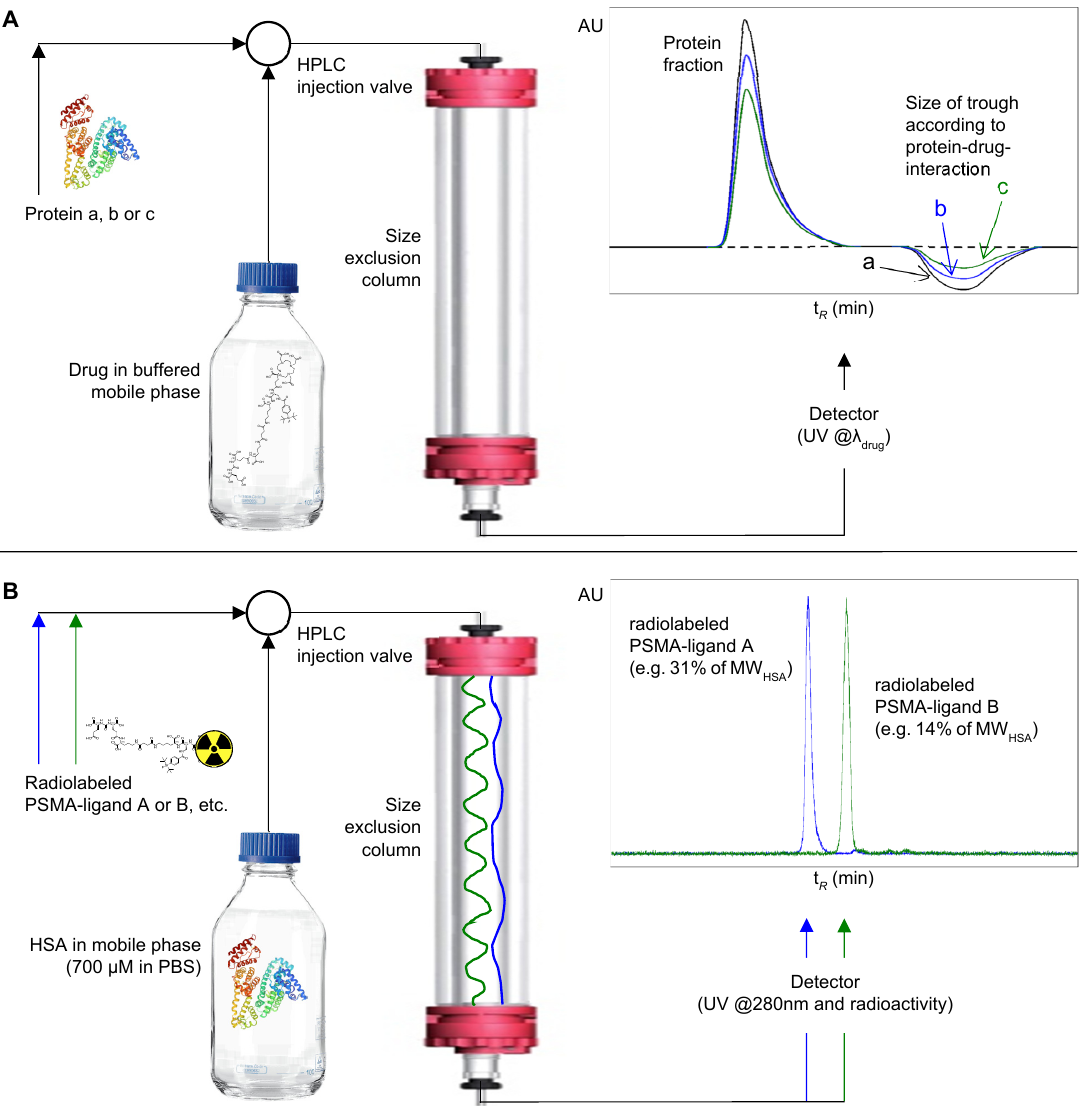
Figure 1. ( A ) Experimental setup of the Hummel–Dreyer method. This method was introduced 1962 to investigate the binding of a drug to proteins. For this purpose, a protein is injected onto a size exclusion column equilibrated with a buffered solution of a drug. After injection, drug molecules from the mobile phase are complexed to the injected protein until equilibrium is reached. The troughs (a, b, c) observed at the cut-off volume in the UV elution profile correspond to the different amounts of drug complexed by the different injected protein samples, thus representing a depleted concentration of the drug at the low-molecular-weight fraction, while the protein fraction shows a stronger signal (protein and complexed drug). ( B ) Experimental setup of the newly developed albumin-mediated size exclusion chromatography (AMSEC). Radiolabeled PSMA ligands are injected onto a size exclusion column equilibrated with a buffered solution of human serum albumin (HSA, physiological concentration of ~700 µM in PBS; pH 7.4). Throughout the chromatographic run, the radioligand binds to and dissociates from HSA in a transient manner. The observed retention time of a radioligand is the result of the mean time the ligand is complexed by HSA, which in turn depends on the strength of the drug–albumin interaction. Thus, an apparent molecular